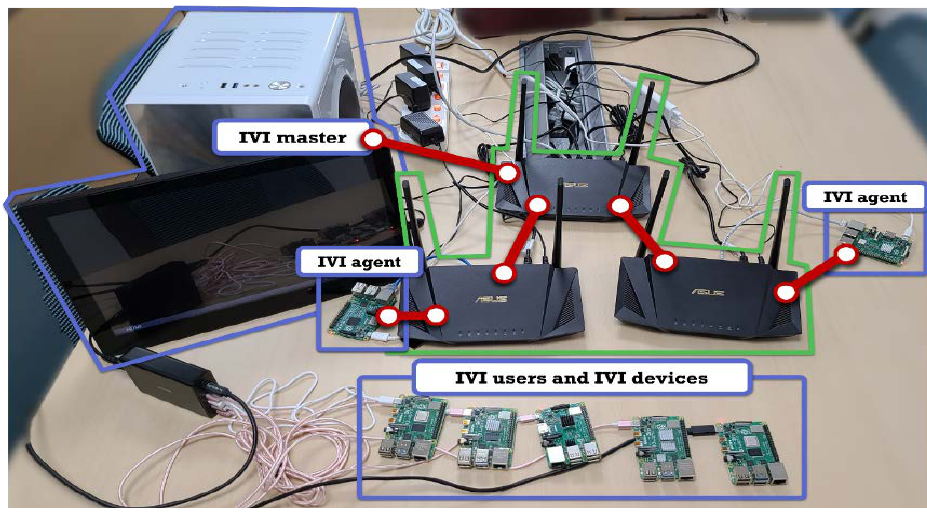
Figure 15. Testbed configuration for implementation of the proposed A-IVI scheme .